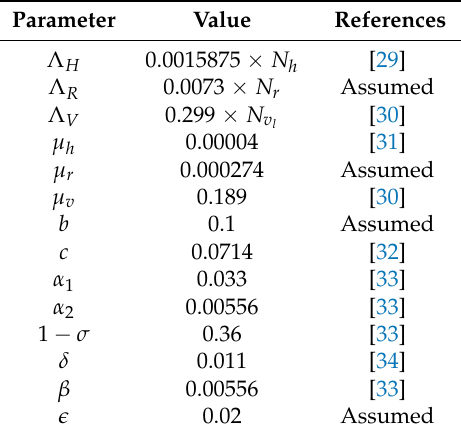
Table 1. Parameter values of the